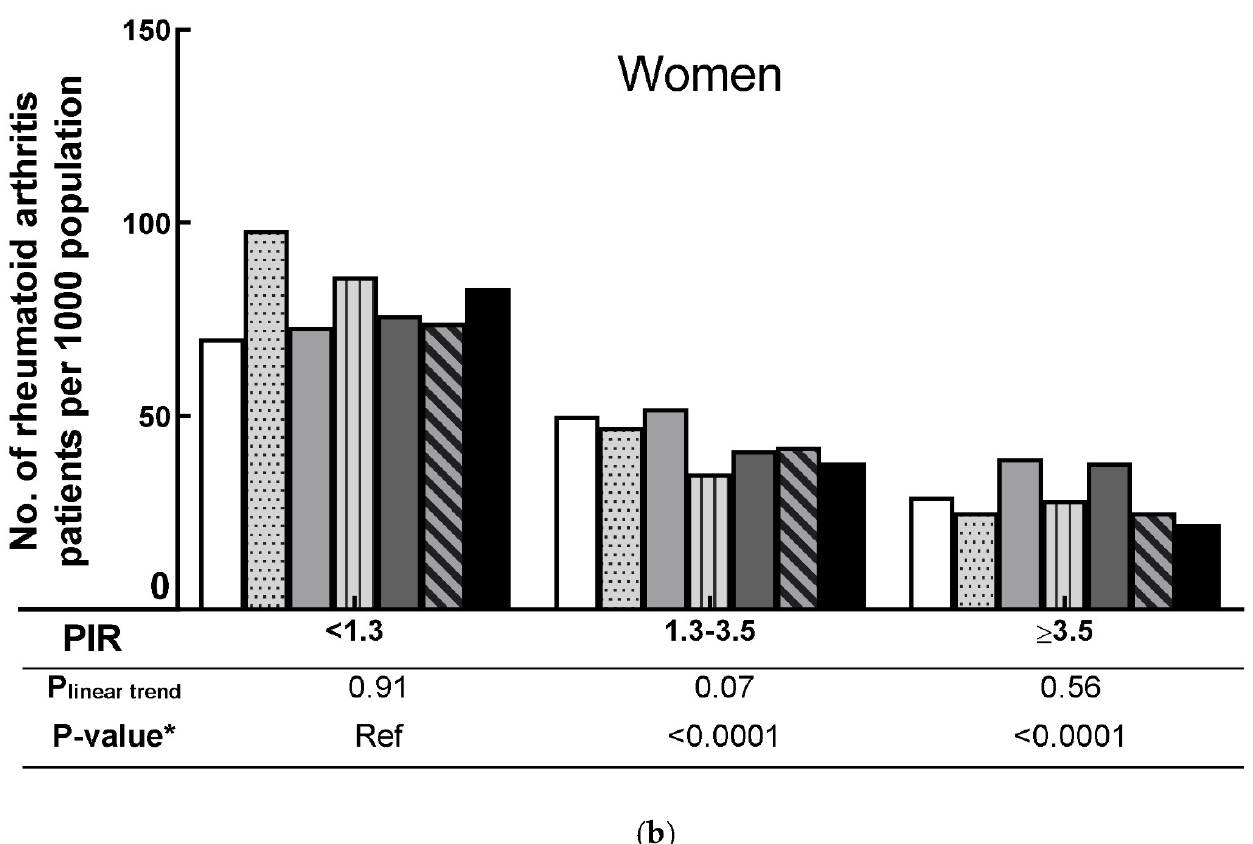
Figure 4. Age-adjusted prevalence of rheumatoid arthritis by poverty income ratio level in men and women, 2005–2006 through 2017–2018. ( a ) shows the prevalence of men by poverty income ratio level; ( b ) shows the prevalence of women by poverty income ratio level. * p -value was based on F-test.